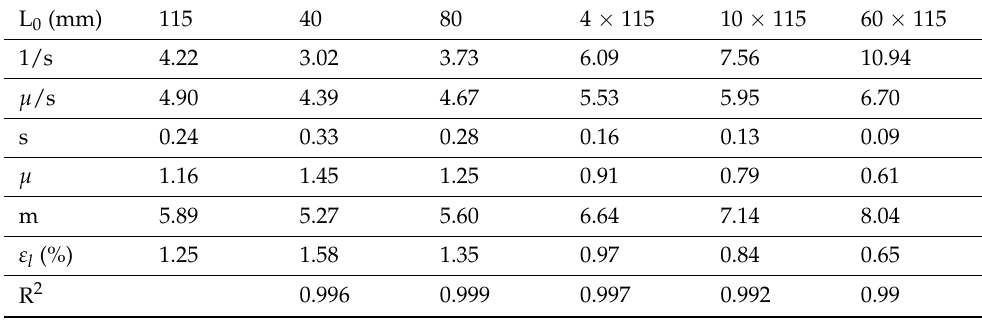
Figure 7. Comparison of experimental p-quantile diagrams with predictions from the 115 mm gauge length p-quantile diagram (as baseline).